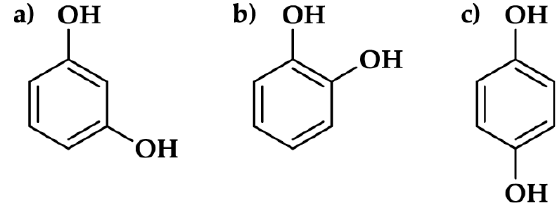
Figure 1. The chemical structure of dihydroxybenzene isomers: ( a ) resorcinol; ( b ) catechol; ( c ) quinol.